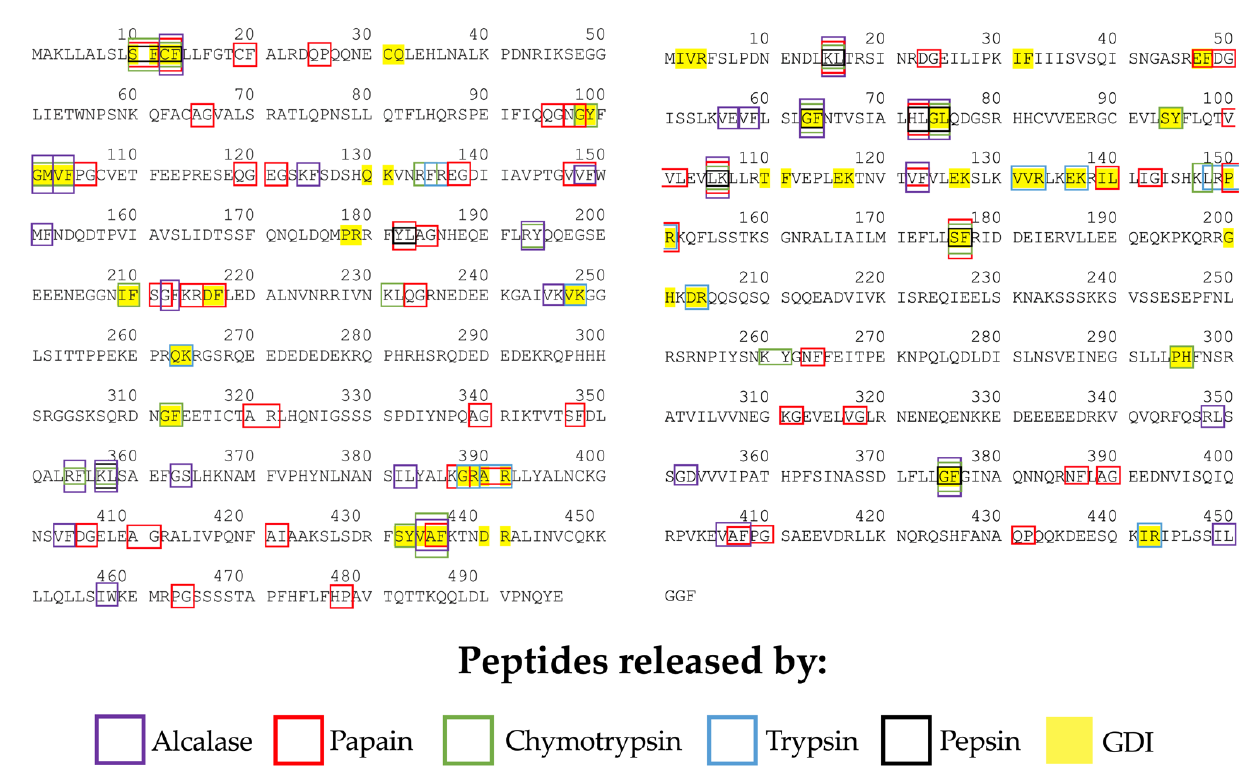
Figure 2. Profile of ACE-I inhibitory peptides released after in silico enzymatic hydrolysis of chickpea ( Cicer arietinum L.) proteins. ( A ) legumin and ( B ) provicilin. The color indicates the enzyme that released the peptides after enzymatic hydrolysis. GID: Gastrointestinal digestion.